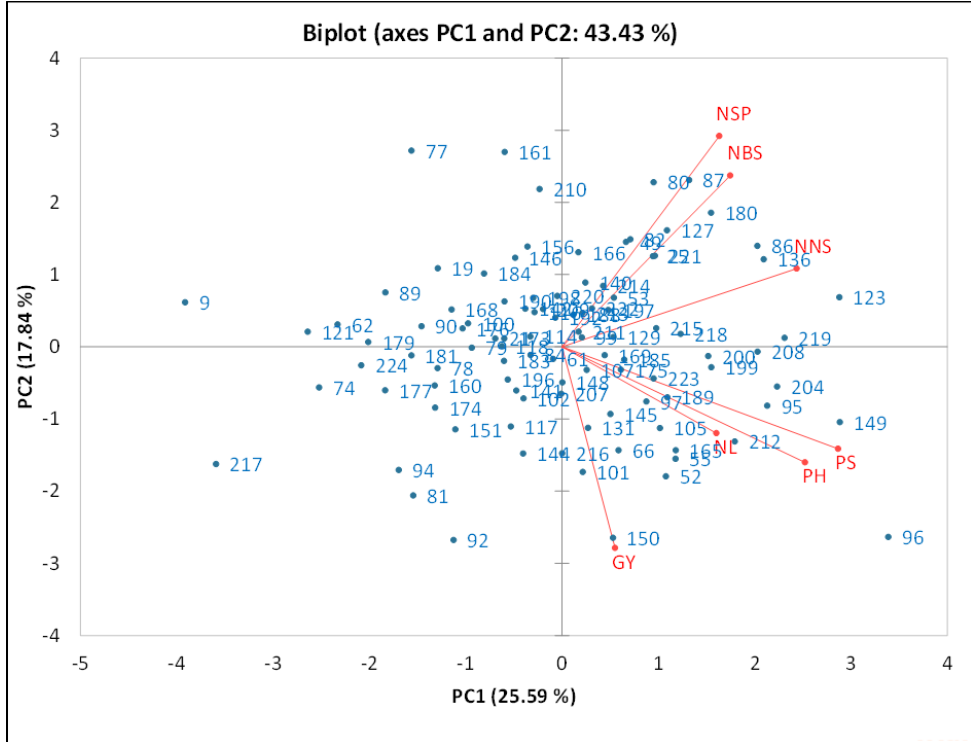
Figure 2. Biplot analysis for principal component 1 (PC1) on the x − axis plotted against principal component 2 (PC2) on the y − axis for the 100 bambara accessions (in numbers) for all traits. PS, plant spread; NNS, number of nodes per stem; NL, number of leaves per plant; NSP, number of stems per plant; NBS, number of branches per stem; GY, grain yield.